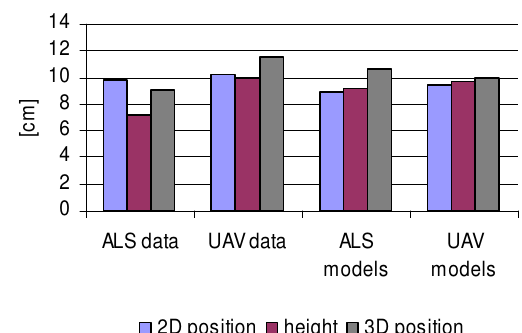
Fig 3.6: Standard deviation of residuals between Check Points, calculated with respect to the data collected by